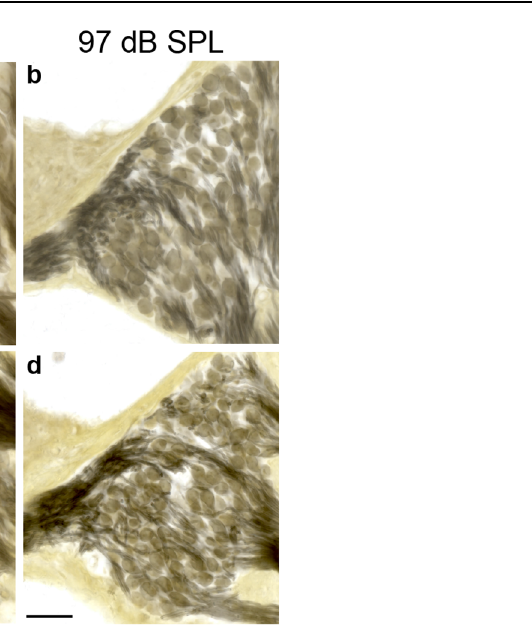
Fig 8. Degeneration of spiral ganglion neurons is assessed in cochlear sections after neuropathic noise. Midmodiolar sections through Rosenthal ’ s canal show permanent loss of spiral ganglion neurons in the apex ( b ) and base ( d ) 16 months after exposure to neuropathic noise (97 dB SPL) compared to age- matched unexposed controls ( a , c ). Scale bar: 50 μ m (a-d).